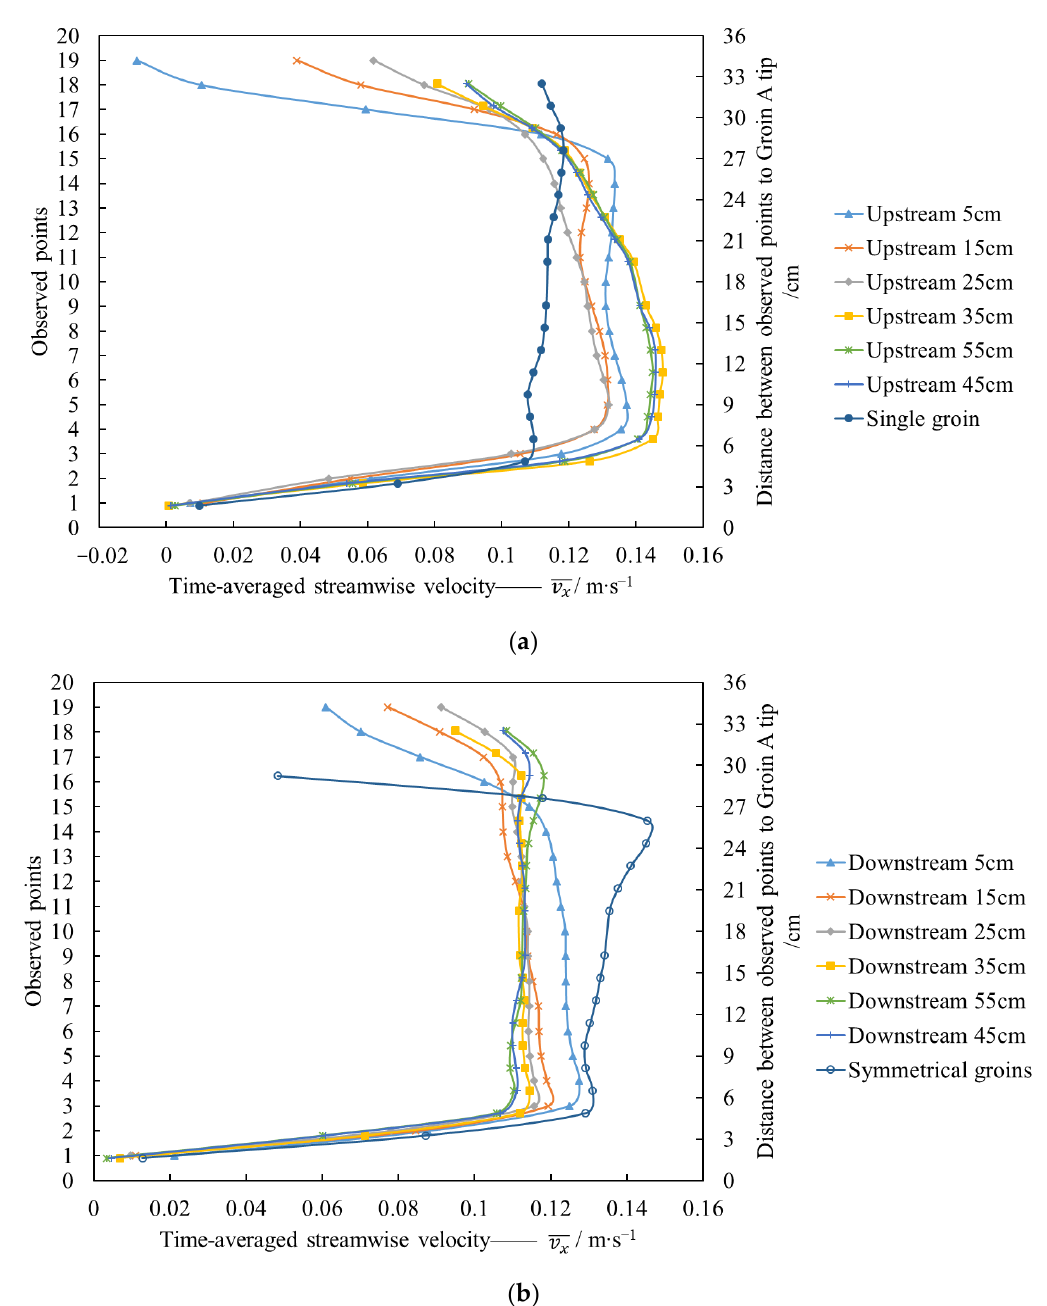
Figure 9. Time-averaged streamwise velocity ( 𝑣 𝑥 ̅̅̅ ) at the observed points along the cross-section located at Groin A tip for ( a ) single groin and Groin B located at upstream of Groin A; ( b ) symmetrical groins and Groin B located downstream of Groin A.